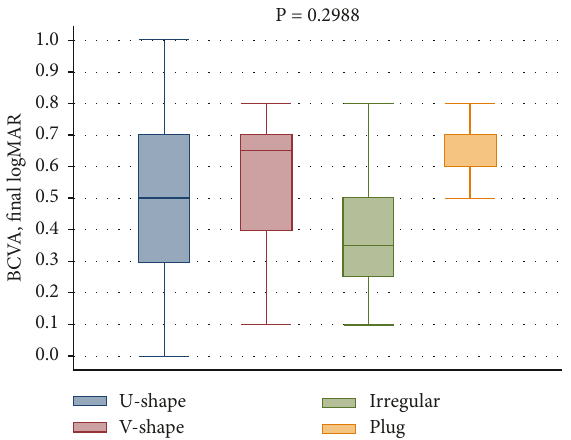
Figure 3: Correlation between each foveal contour and final BCVA.